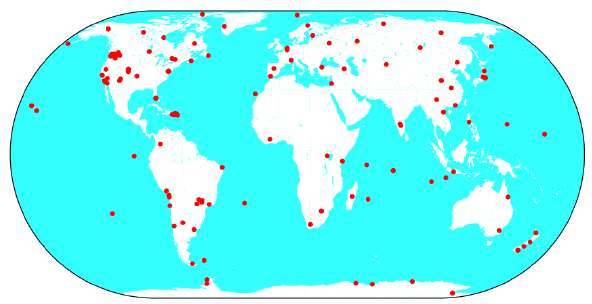
Figure 1. The largest real-time tracking network on the ground (the Global Differential GPS (GDGPS) System; from